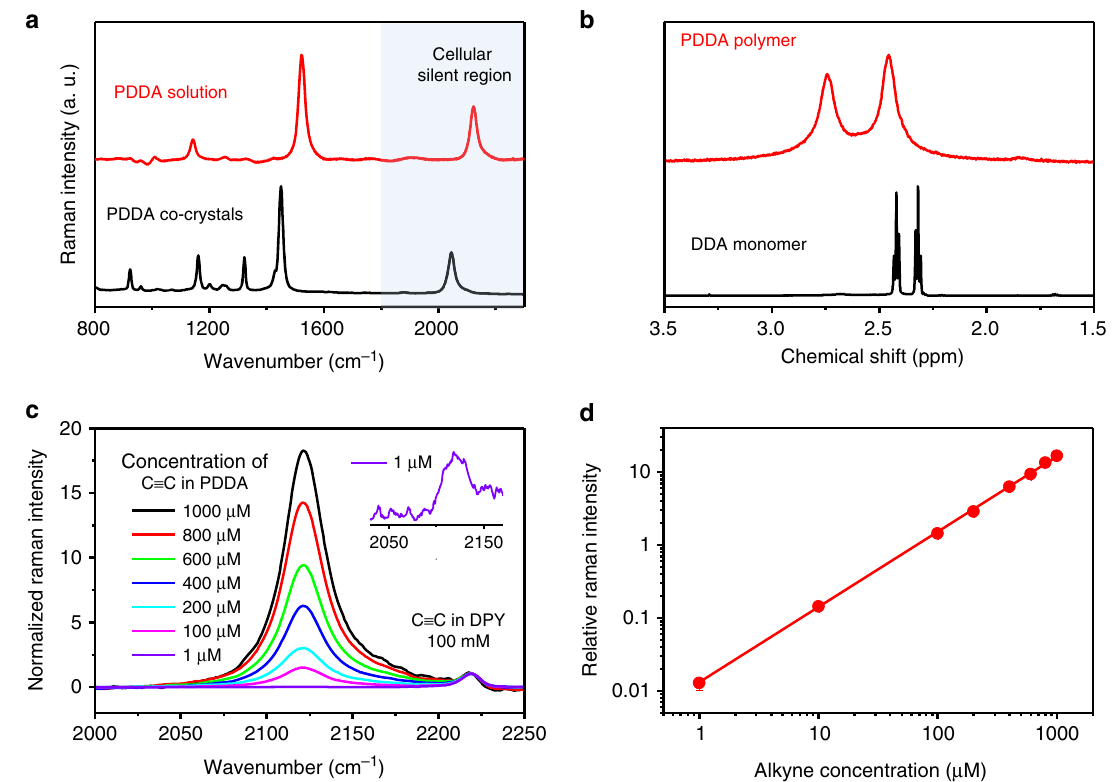
Fig. 3 Characterization of PDDA polymer in solution. a Raman spectra of PDDA aqueous solution and PDDA co-crystals. b Solution-phase 1 H NMR spectra of PDDA polymer and DDA monomer (solvent: D 2 O). c Raman spectra of mixed DMSO solutions of PDDA and DPY. The concentration of DPY in each solution is 50 mM (100 mM C ≡ C bond), and the calculated concentration of the C ≡ C bonds in PDDA is from 1 to 1000 μ M. The Raman intensity of each spectrum is normalized to the DPY peak intensity. d Relative Raman intensity at 2120 cm − 1 of PDDA aqueous solutions plotted as a function of the concentration of C ≡ C bonds in PDDA. Solid line shows a linear fi tting in the double logarithmic plot (R 2 = 1.000). Laser for Raman excitation λ Ex = 488 nm, 0.5 mW.